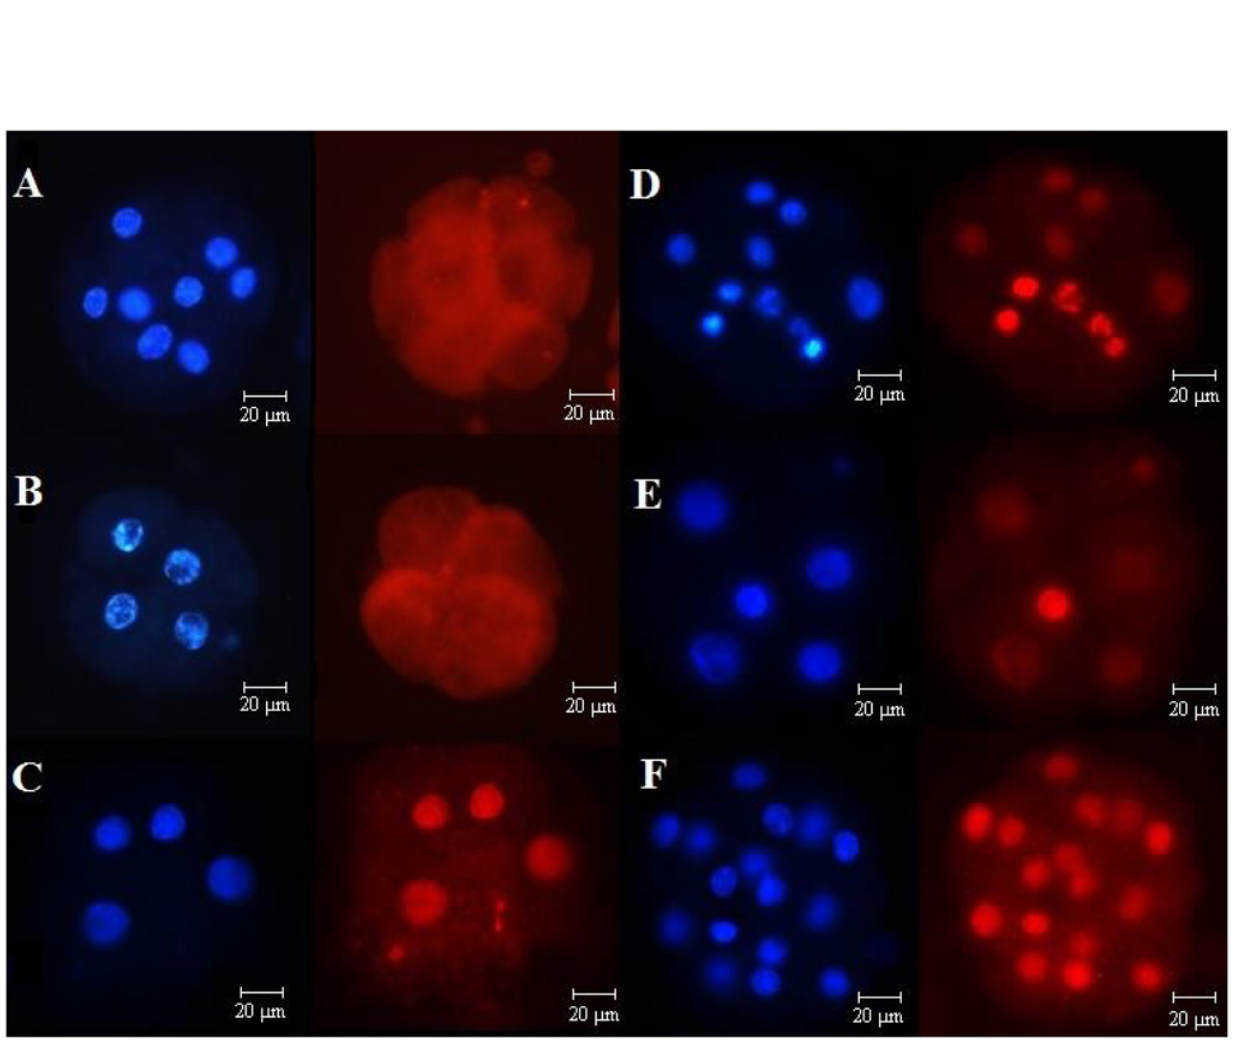
doi:10.1371/journal.pone.0119463.t006